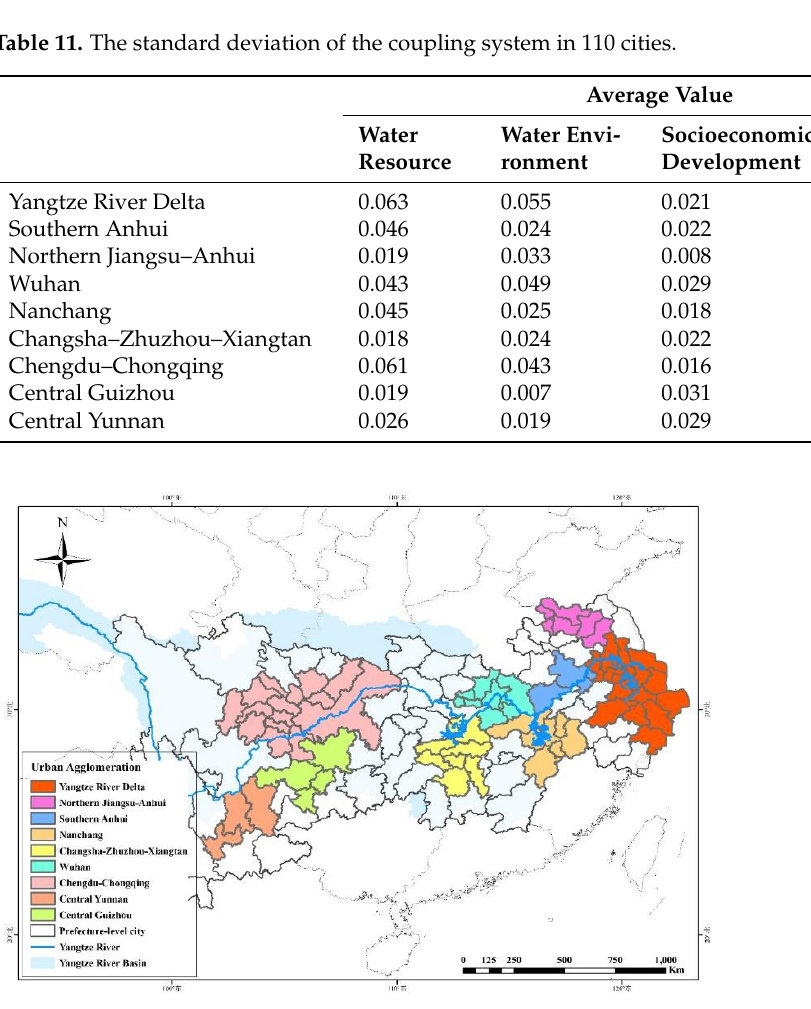
Figure 11. The urban agglomeration spatial pattern in 110 cities. Table 11. The standard deviation of the coupling system in 110 cities.